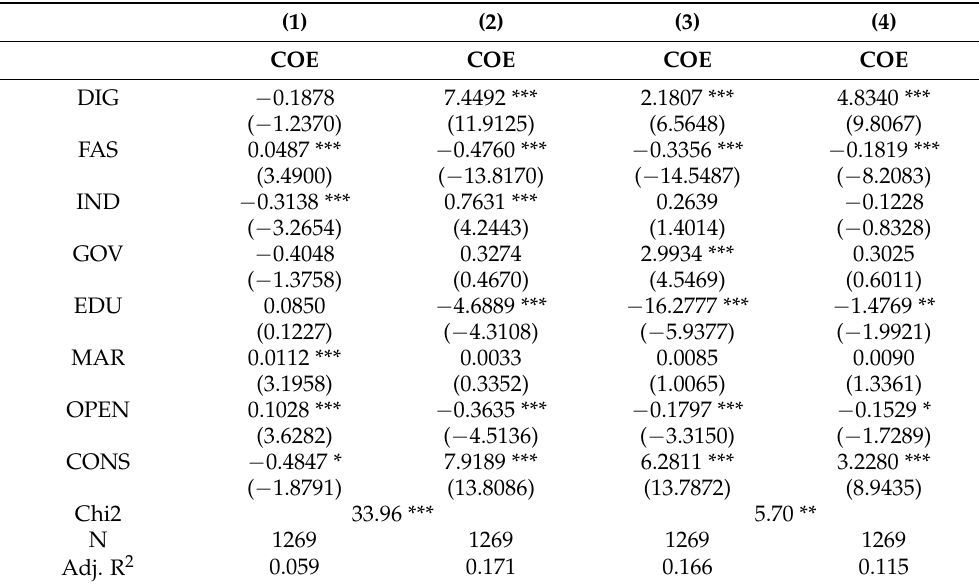
Table 12. Test of population heterogeneity and economic development level